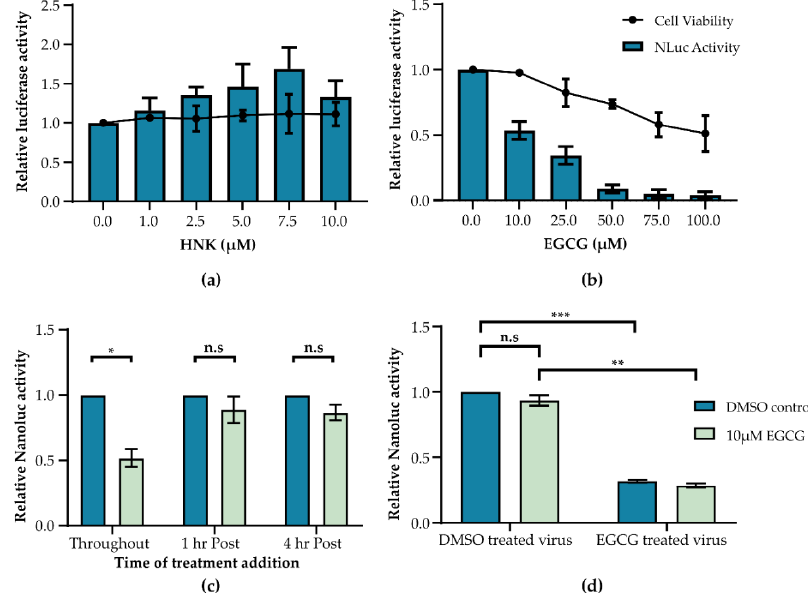
Figure 2. EGCG inhibits ZIKV independent of GRP78. A549 cells were treated with either ( a ) honokiol (HNK) or ( b ) epigallocatechin-gallate (EGCG) at indicated concentrations for 26 h. Cell viability was measured relative to a DMSO control as indicated by the line graph. Separately, A549 cells were treated with the same drug concentrations for 2 h prior to infection with ZIKV-Nanoluc (MOI 0.1) for 24 h. Nanoluc readings are relative to a DMSO control indicated by the bar graph. ( c ) EGCG (10 µM) was added to A549 cells and maintained throughout a 24 h ZIKV-Nanoluc infection or added 1 h or 4 h post-removal of virus inoculum. Nanoluc values were measured relative to a DMSO vehicle control. ( d ) ZIKV-Nanoluc was incubated with either DMSO or EGCG (10 µM) independently of cells for 2 h at 37 °C. Simultaneously, A549 cells were treated with DMSO or EGCG for 2 h before the drug containing media was replaced with drug treated or DMSO treated control virus for 1 h. Following this, virus inoculum was removed and replaced with DMEM containing either DMSO or EGCG as before for a further 23 h. Error bars represent the standard error of the mean of triplicate repeats. An unpaired Student’s t -test with Welch’s correction was used to determine statistical significance where n.s = not significant, * p -value < 0.05, ** p -value < 0.01 and *** p -value < 0.001. ( a – d ) n =